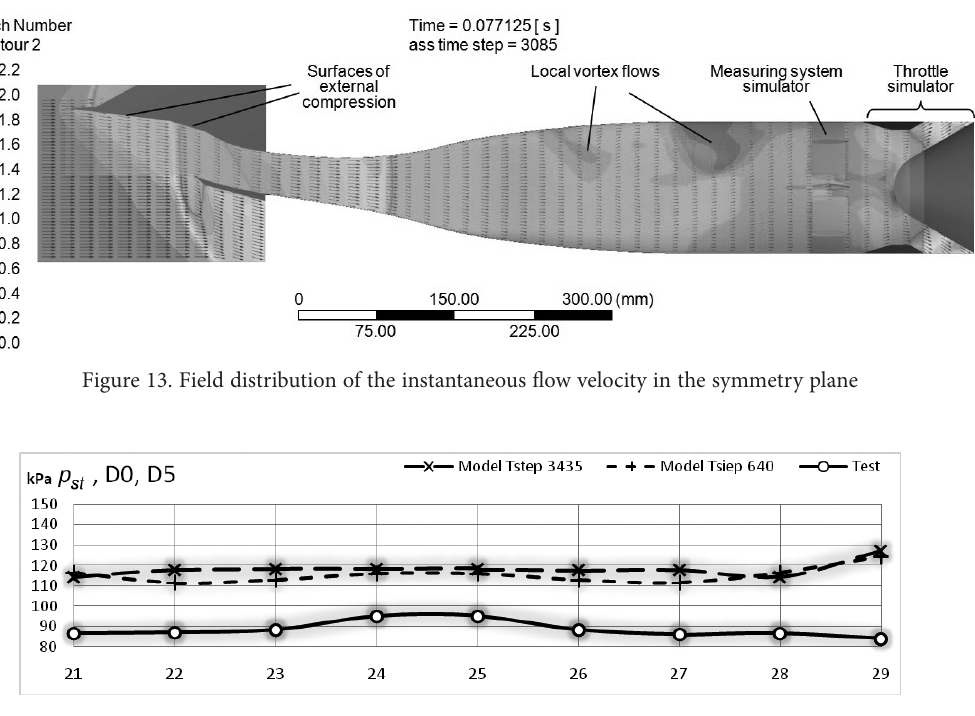
Figure 14. Field distribution of the instantaneous flow velocity in the symmetry plane